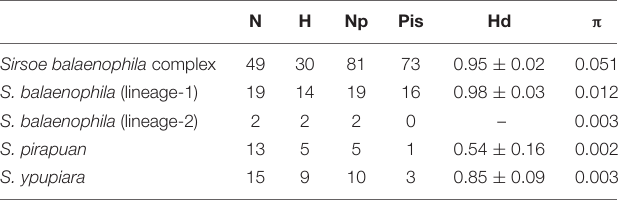
TABLE 2 | Summary of genetic variability of COI for Sirsoe balaenophila species complex and for each lineage. N H Np Pis Hd